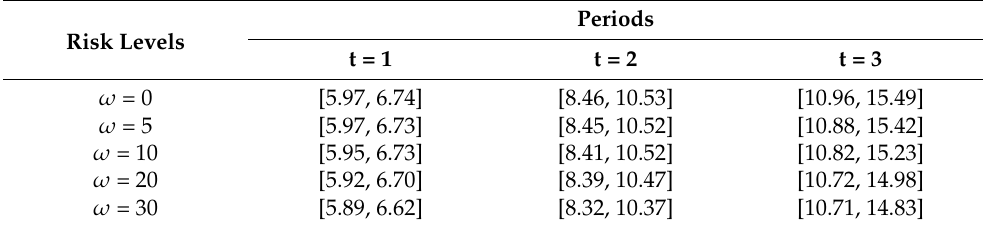
Table 3. Benefits of water resource utilization at different risk levels in the Fenhe River Basin (CNY 10 6